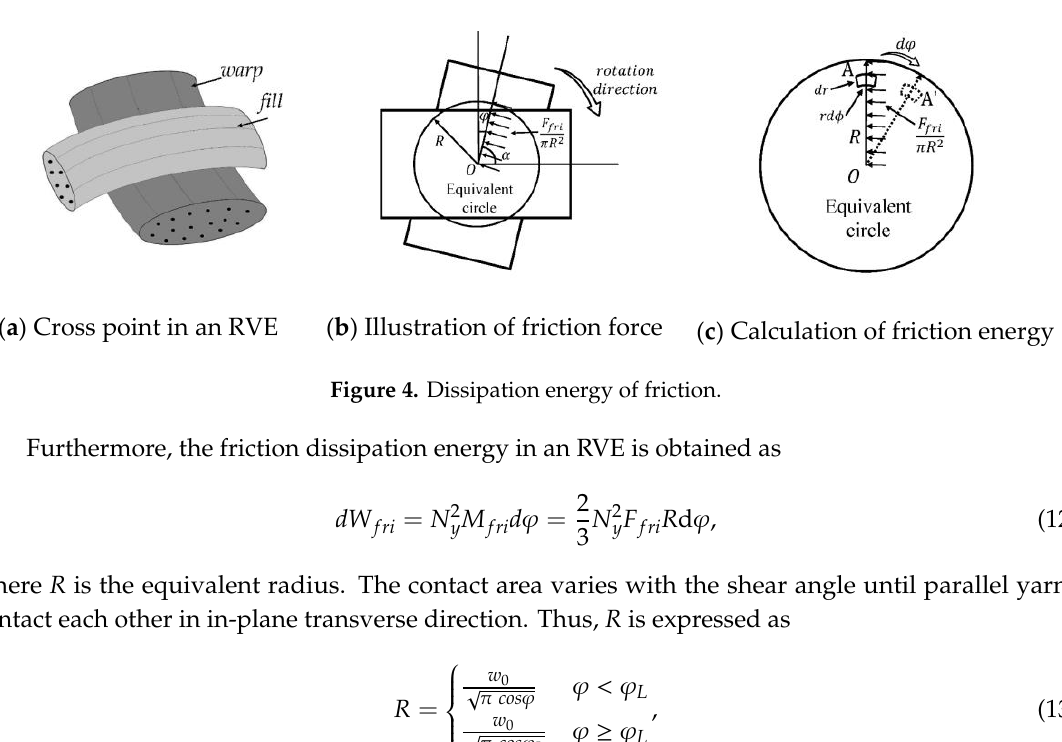
Figure 5. The contact force produced by the tension force of a yarn (plain-woven fabric).